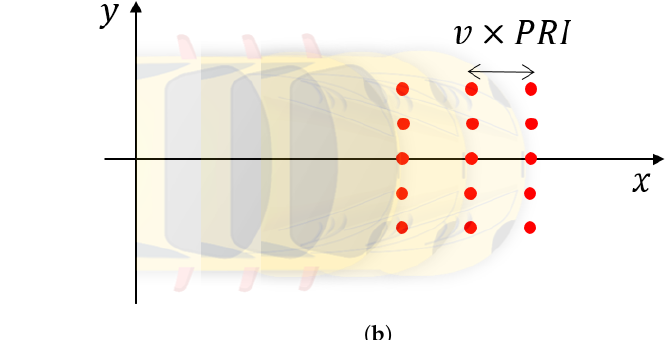
Figure 1. Geometry of the system. The red dots are the virtual channels of the MIMO radar with a distance d , φ is the azimuth angle, and the black dot is a generic location is the field of view. In this figure, the installation angle is φ inst = 0 deg, representing a forward-looking geometry ( a , b